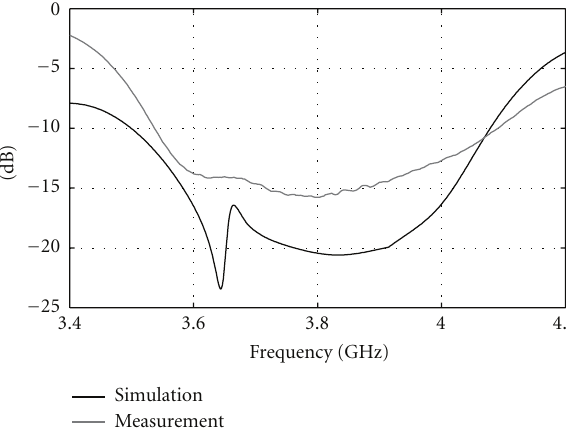
Figure 8: Simulated and measured return